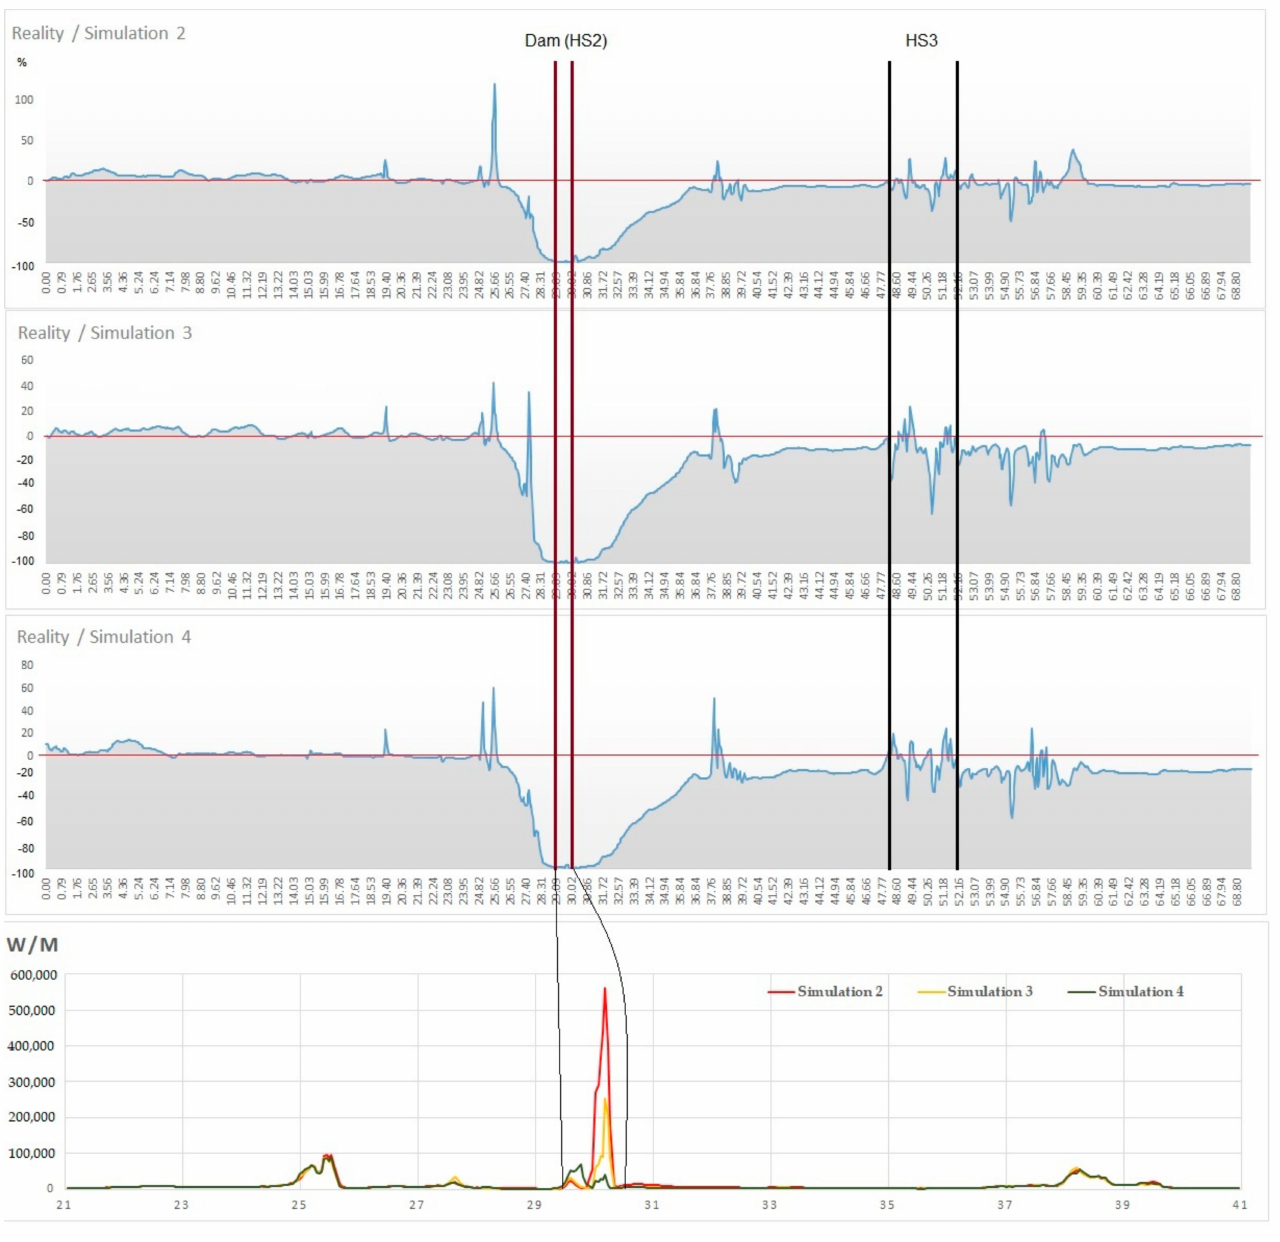
Figure 16. Comparative graphs of stream power value on longitudinal profiles. The analysis of behaviour in the longitudinal profile of the erosion process highlights the very large decrease in erosion in hotspot 2 (HS2) by almost 100% compared to simulation 1, which had an exploratory purpose. There is a decrease in erosion power along the entire length of the longitudinal profile with an average of about 20%, being evident especially in simulation 3 and 4. In simulation 2, there is a decrease in erosion power downstream of the proposed hydro-amelioration work. The values are relatively small, approx. 10% (Figure